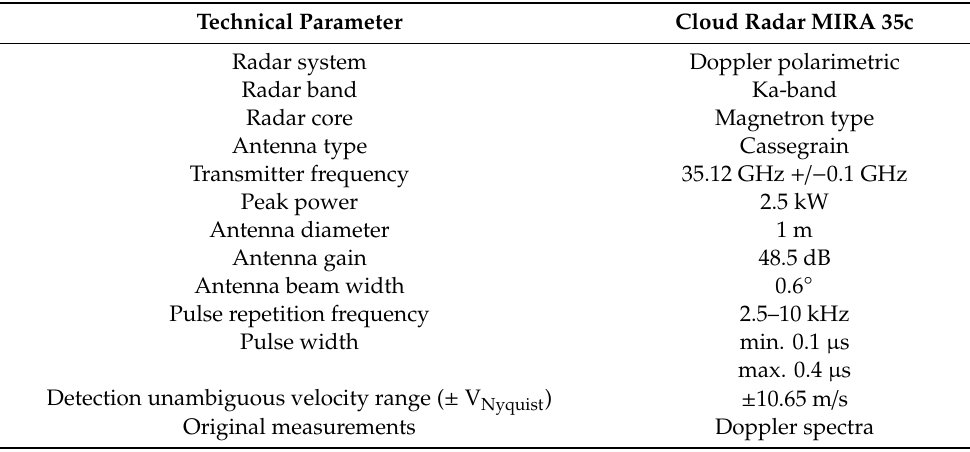
Table 1. Technical parameters of the cloud radar MIRA35c situated at the Milešovka